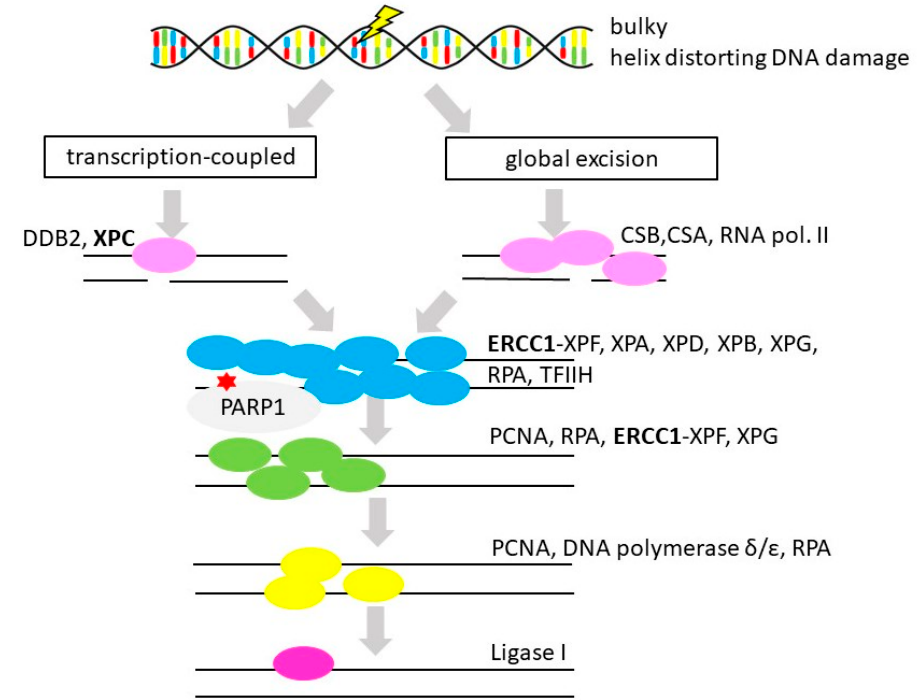
Figure 6. Nucleotide excision repair. Simplified scheme of nucleotide excision repair of bulky lesions and helix distorting DNA damage DNA (gene alternations in OvC in bold, therapeutic interventions considered in OvC therapy marked by a red star (PARP inhibitors)) [150]. Protein names: damage specific DNA binding protein 2 (DDB2), xeroderma pigmentosum complementation group A, B, C, D, F, G (XPA, -B/ERCC3, -C, -D/ERCC2, -F/ERCC4, -G), Cockayne syndrome A and B (CSA and B), RNA polymerase II (RNA pol. II), excision repair cross-complementation group 1 (ERCC1), replication protein A (RPA), transcription factor II Human (TFIIH), poly(ADP-ribose) polymerase 1 (PARP1), proliferating cell nuclear antigen (PCNA), DNA polymerase delta and epsilon (POLD and E), DNA ligase 1 (LIG1)